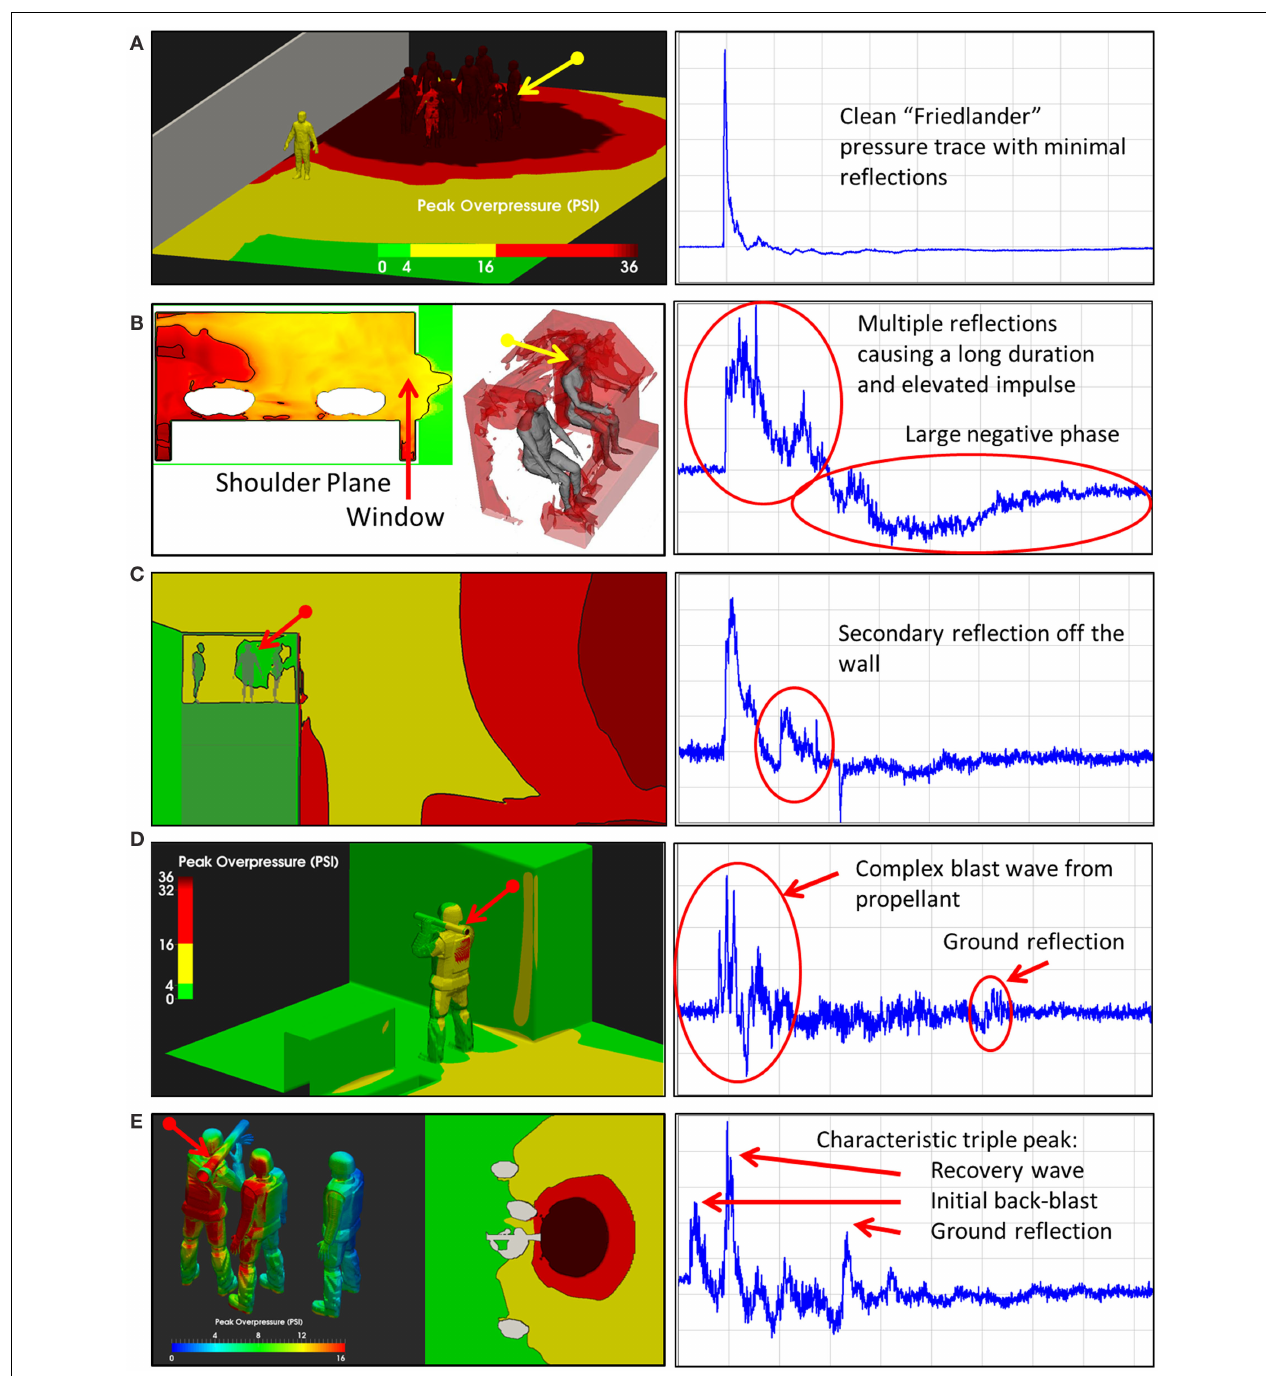
FIGURE 3 | Blast exposure scenarios . As illustrated in these five scenes, the pressure-time history associated with an explosion varies considerably with respect to the environment in which the exposure occurs. Multiple reflective surfaces can increase the duration of exposure or cause multiple reflections, increasing the impulse imparted to an individual in the environment (Wiri S, Needham C Reconstruction of IED blast loading to personnel in the open. Twenty-first International Shock Interaction Symposium, International Shock Wave Institute, 3–8, August, 2014, Riga,